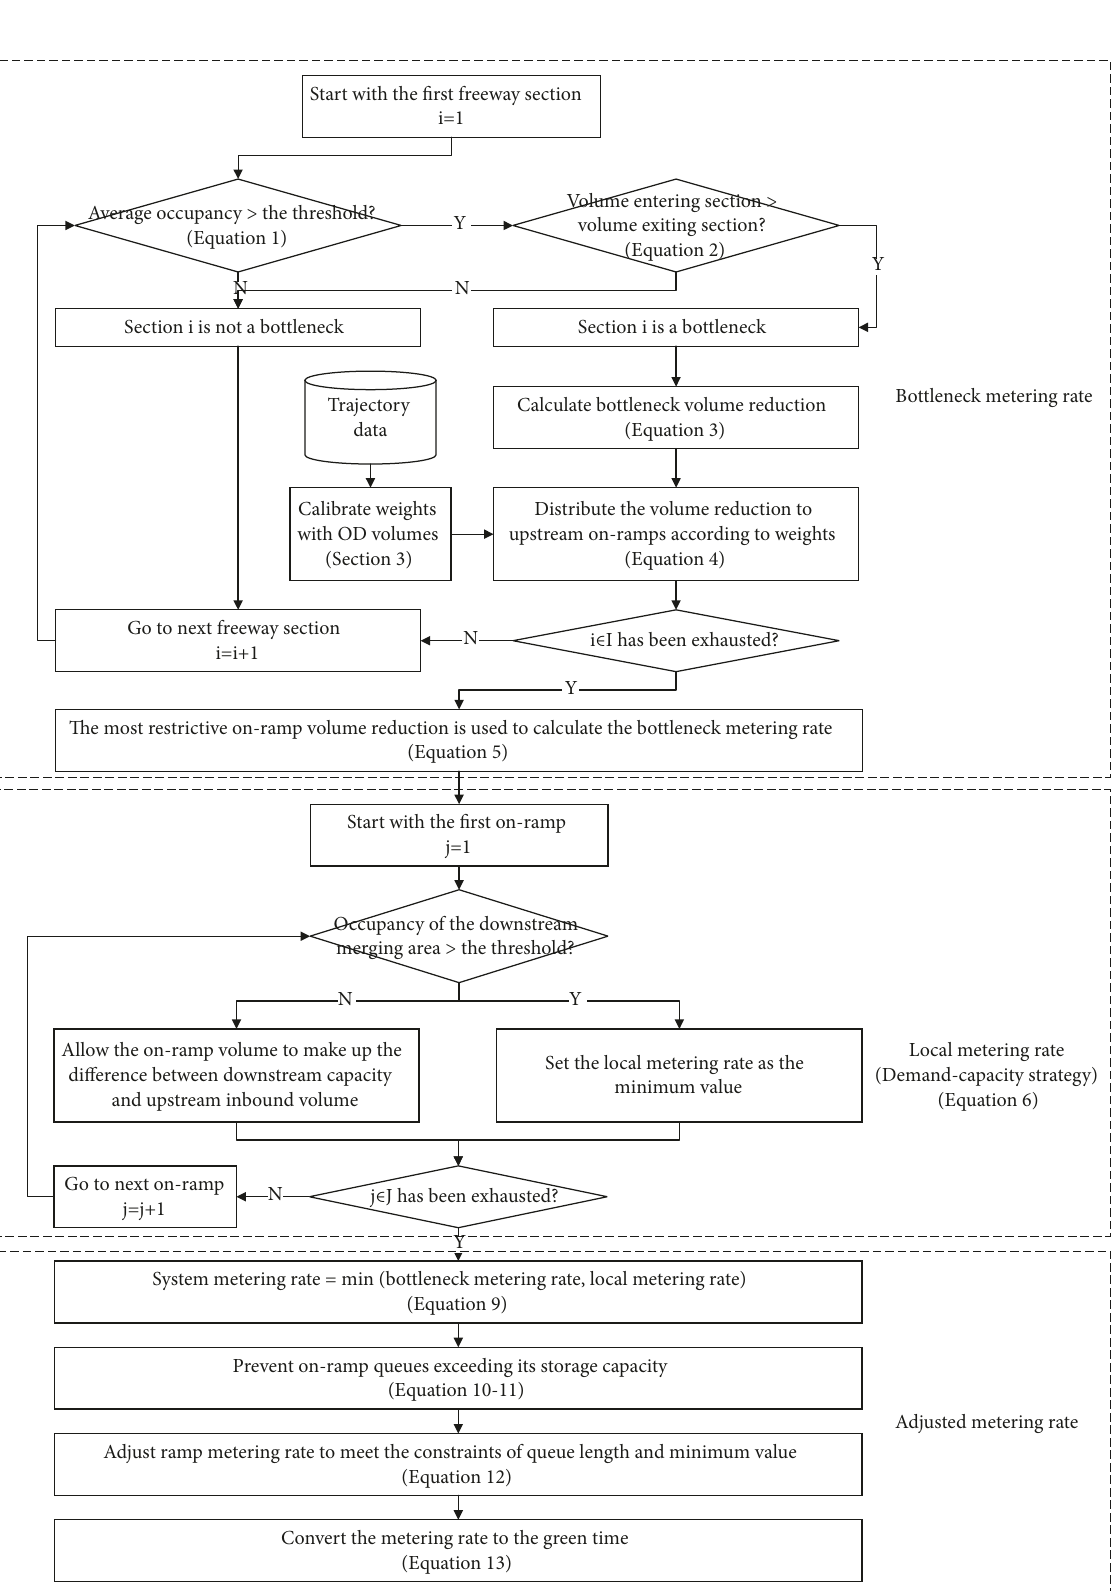
Figure 2: The flow chart of the bottleneck